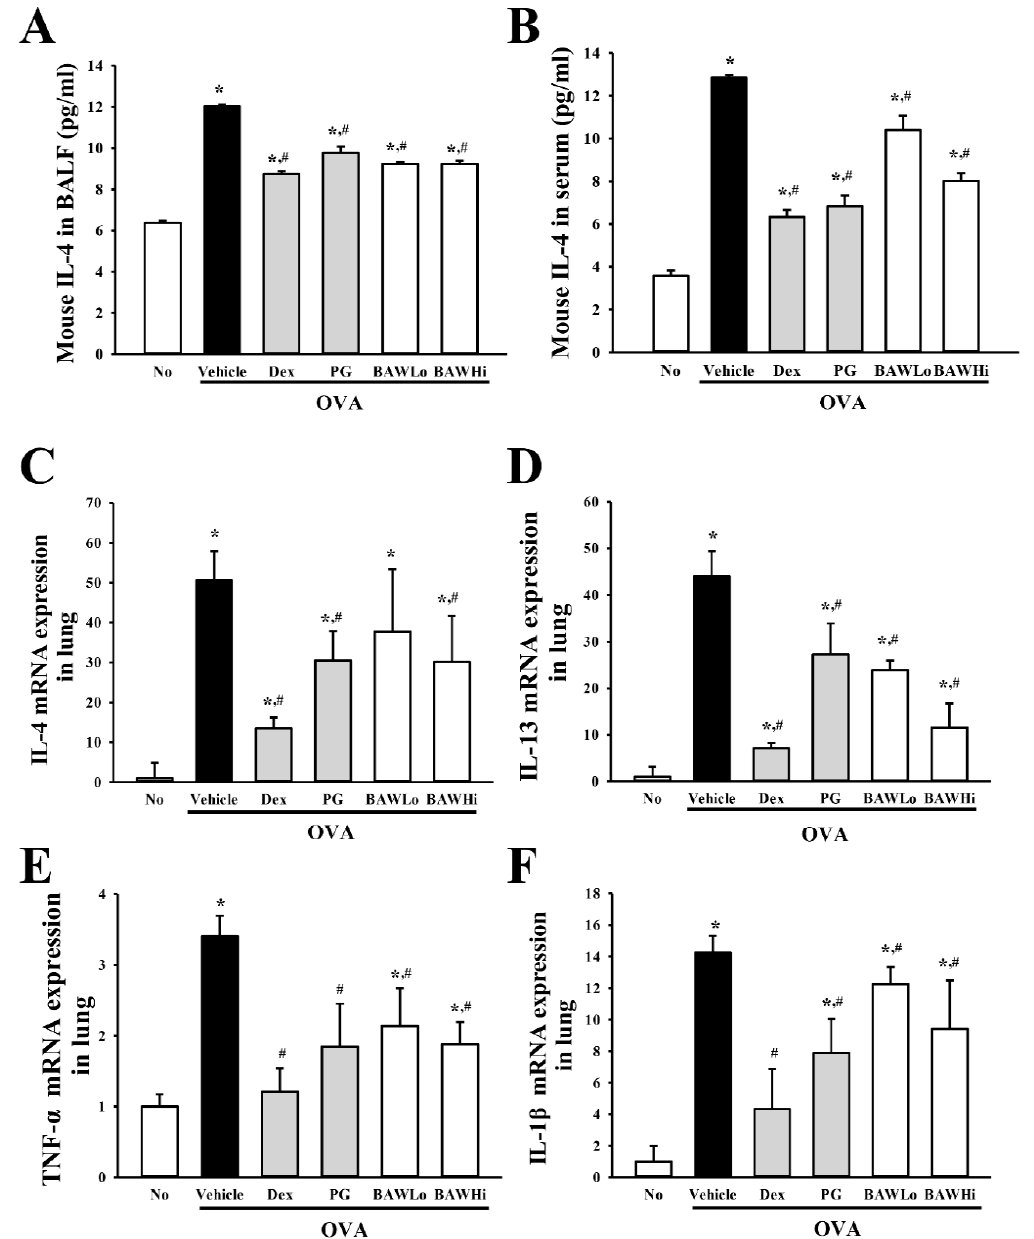
Figure 5. Level of inflammatory cytokines. After collecting the supernatant from BALF and serum from the OVA-induced asthma model were treated with BAW, the concentrations of IL-4 were measured in BALF ( A ) and serum ( B ) using an IL-4 ELISA kit that could detect IL-4 at 0.5 pg/mL. The levels of IL-4 ( C ), IL-13 ( D ), TNF- α ( E ), and IL-1 β ( F ) mRNAs in lung tissue were detected using real-time PCR analysis using specific primers. The relative level of mRNA for each specific cytokine was calculated based on the intensity of β -actin mRNA as an endogenous control. The data shown represent the means ± SD ( n = 8). * indicates p < 0.05 compared to the No-treated group. # indicates p < 0.05 compared to the OVA + Vehicle-treated group.